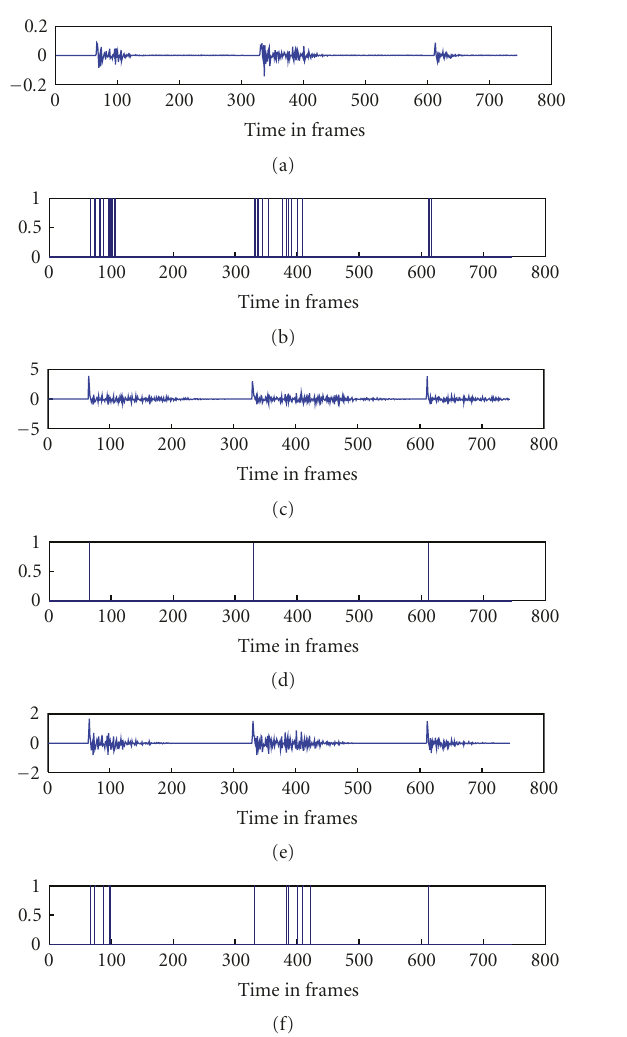
Figure 11: Comparison between the detection functions for the gunshot signal (see Figure 9(b)). Plots (a), (c), and (e) are detection ( k ), h o ( k ), and h o ( k ), respectively, and plots (b), functions h o a r b (d), and (f) are the onsets localised correspondingly using these detection functions. Gunshot signals fluctuate more strongly as compared with violin, guitar, and piano signals. The onset peaks ( k ) and h o ( k ) are not as strong as those revealed by functions h o a b ( k ). revealed by h o r